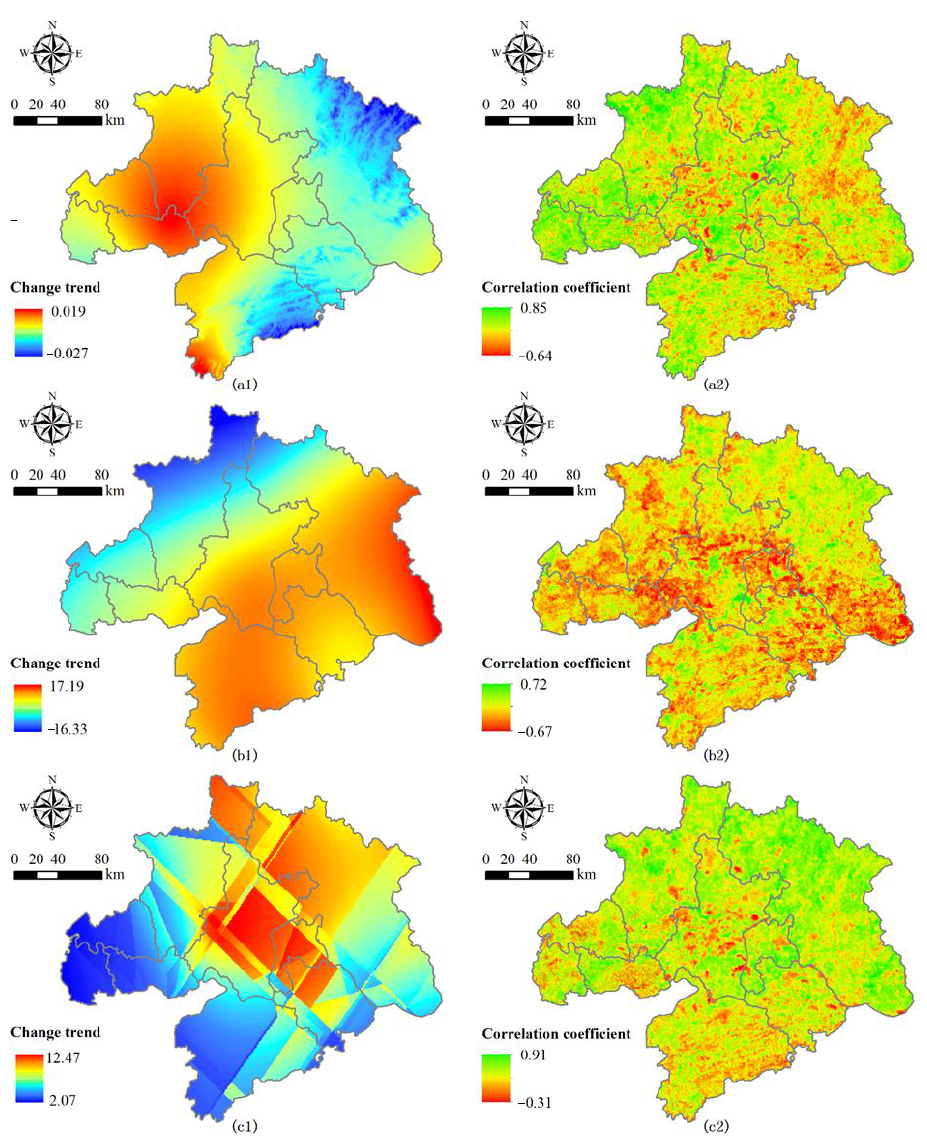
Figure 4. Climate change trends and Spearman’s rank correlations between the annual NPP and climate variables for the period 2000−2015. ( a ) Temperature, ( b ) Precipitation, ( c ) Radiation. Radiation is known to have very important effects on many biological processes, such as photosynthesis and growth in terrestrial vegetation [3]. In the Wuhan City Circle area, the average annual radiation was 4,713.27 MJ × m −2 between 2000 and 2015, and the change rate was 1.72 MJ × m −2 × year −1 (Table S3). Usually, forest carbon sequestration was positively related to radiation [5,20,37]. For example, Jiang et al. [38] showed that reduc- tion in cloud cover increased solar radiation reaching the Earth’s surface, thereby in- creasing NPP. Mercado et al. [39] demonstrated that solar radiation was the main driver of plant photosynthesis. Thus, the increase of solar radiation is beneficial to the formation of carbon sinks. This is completely consistent with our simulation results, as NPP in- creased with radiation in the northeastern regions but decreased in the more central re- gions (Figure 4(c2)). However, there was a significant increasing trend in radiation in